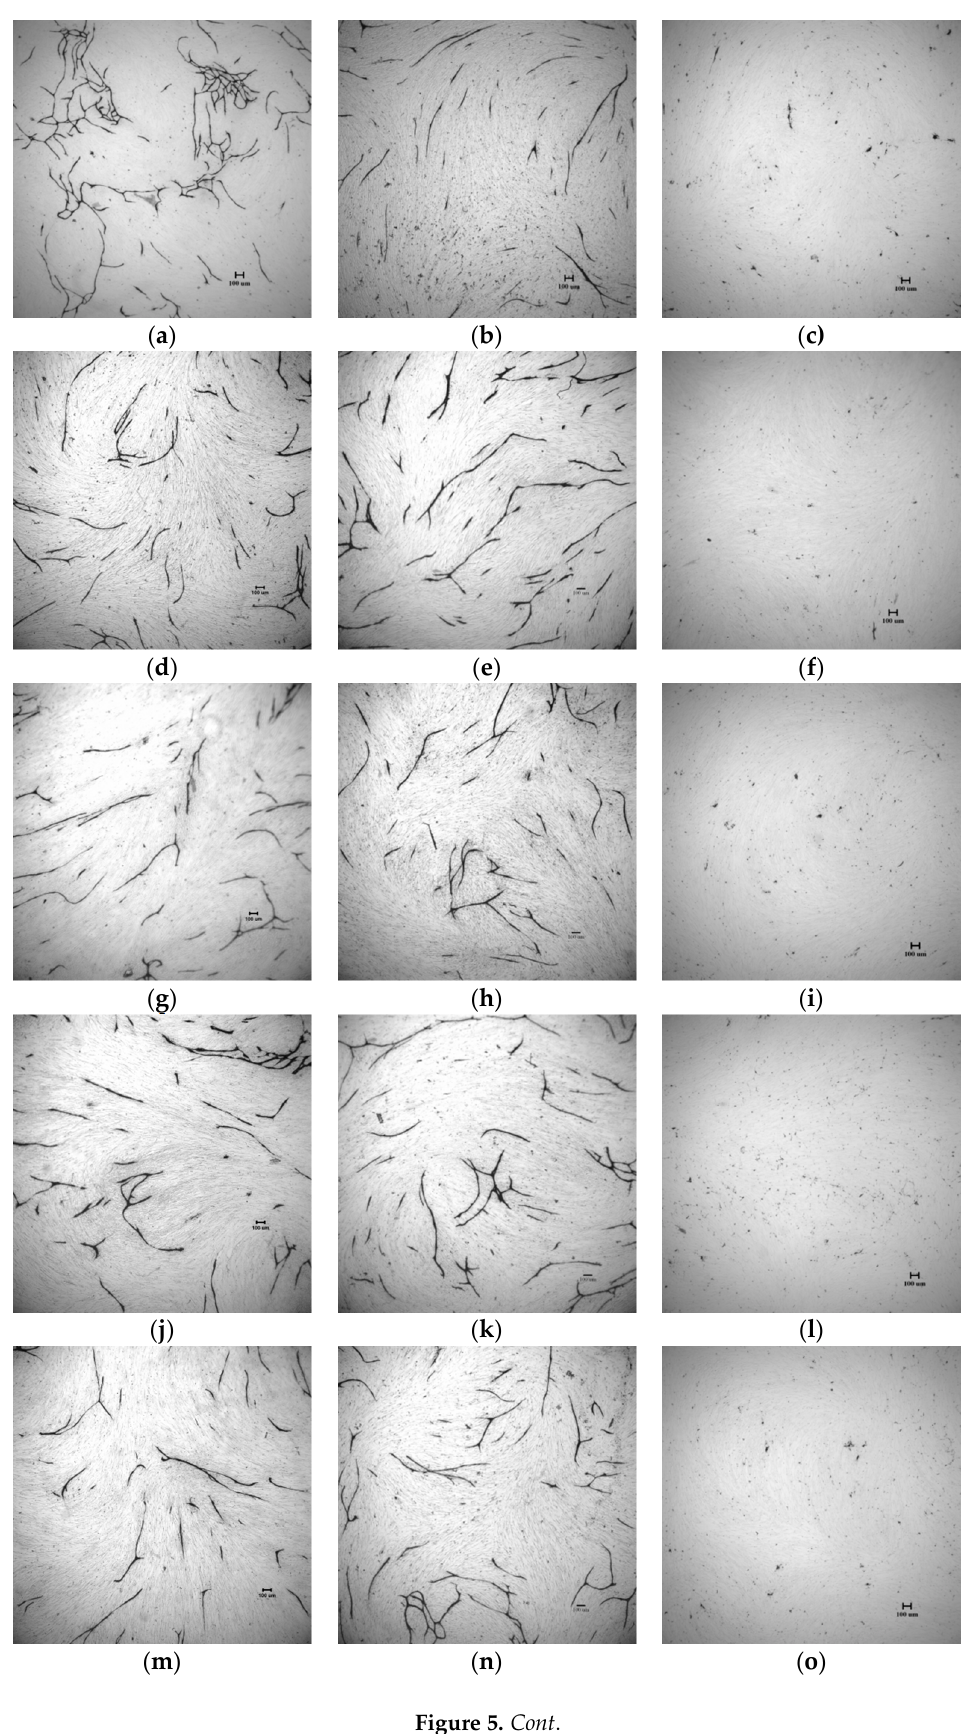
Figure 5 . Cont. Figure 5. Cont